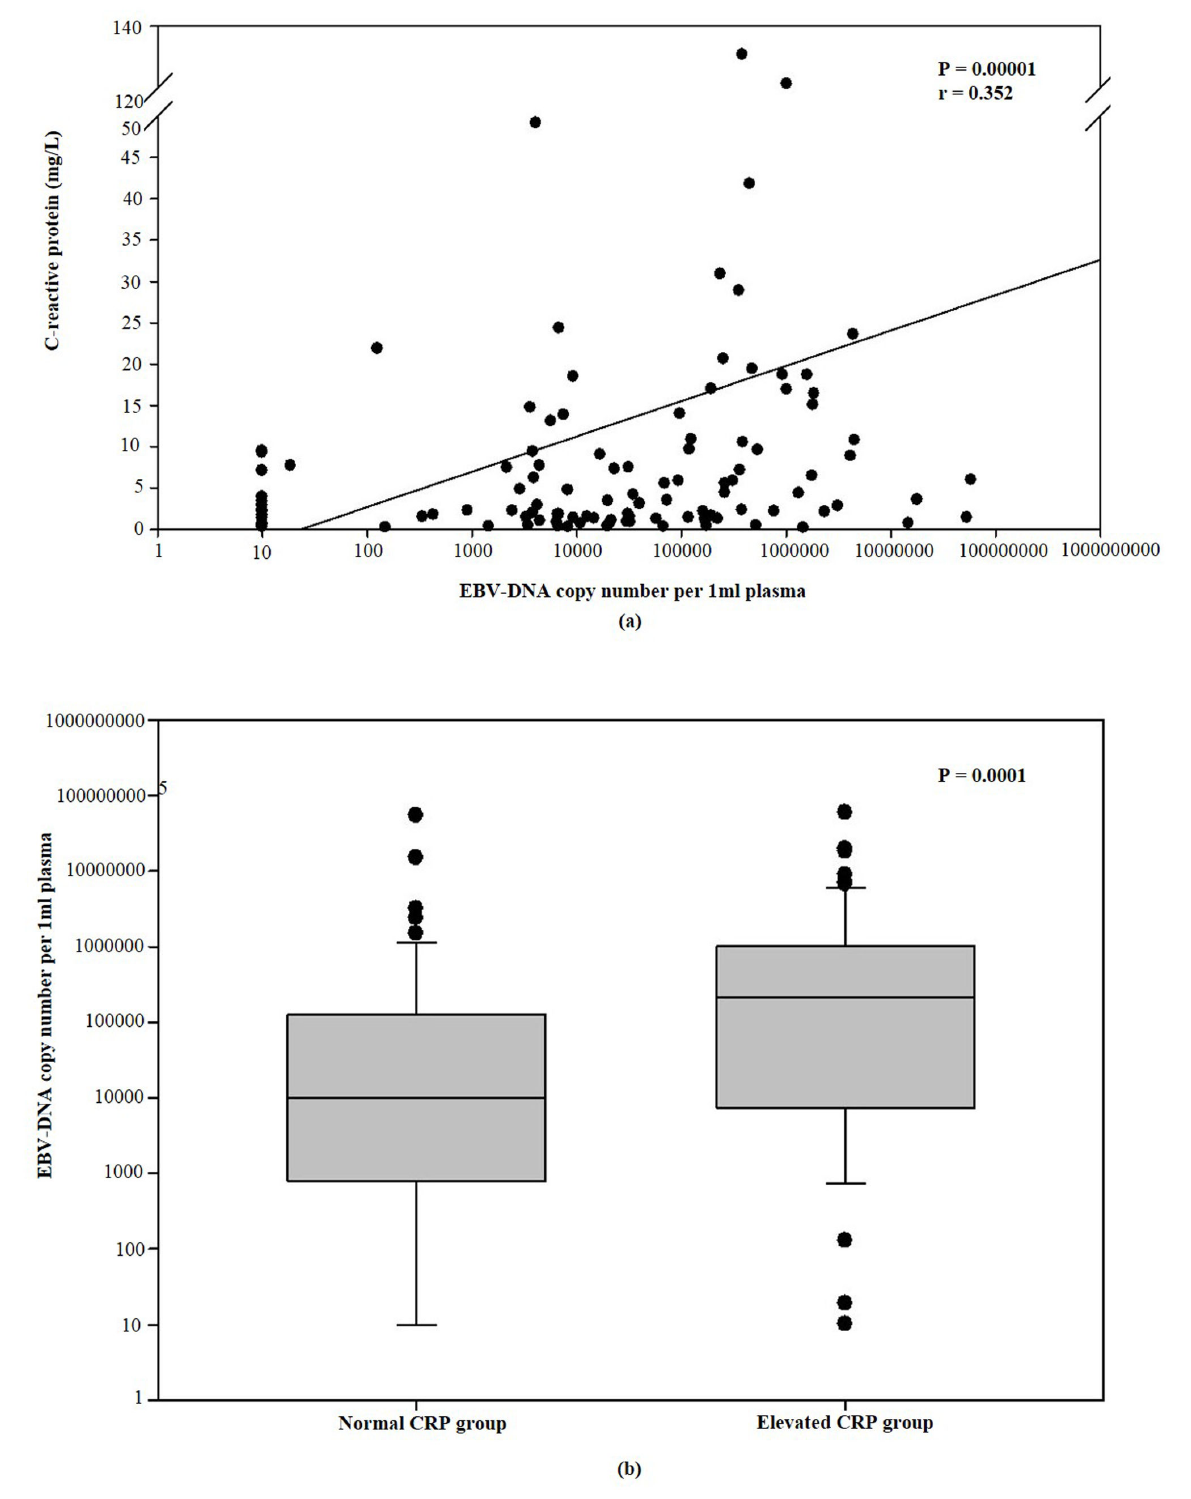
Figure 2. The relationship between the baseline serum C-reactive protein and plasma EBV-DNA copy. (A) Correlation between baseline serum C-reactive protein and plasma EBV-DNA copy ( P < 0.0001, r = 0.352). (B)The plasma EBV-DNA copy of NPC patients with higher baseline CRP levels was significantly higher than those with lower baseline CRP levels ( P = 0.0001). doi: 10.1371/journal.pone.0076958.g002 PLOS ONE | www.plosone.org 5 October 2013 | Volume 8 | Issue 10 |